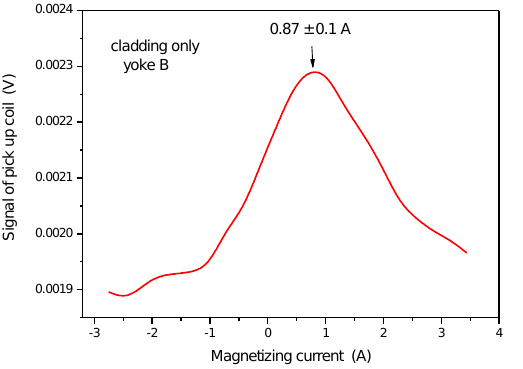
of the cladded block by applying Yoke B.